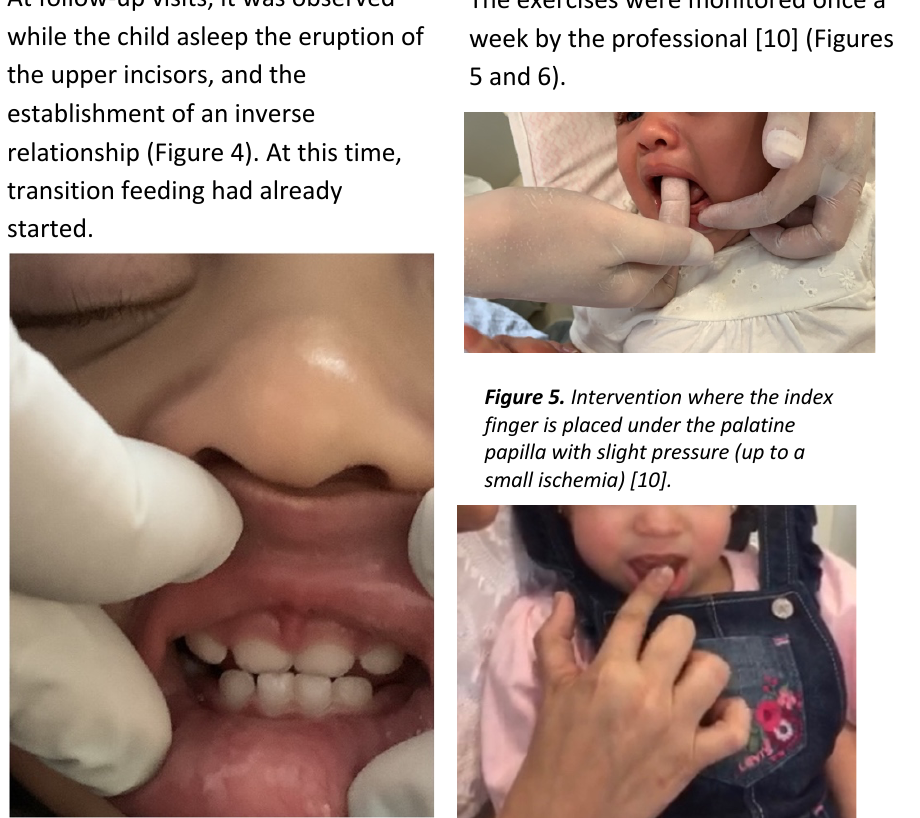
Figure 6. Mandibular posture was guided with the index finger in the cervical region of the lower incisors or chin region, guiding the mandible in a more backward position.